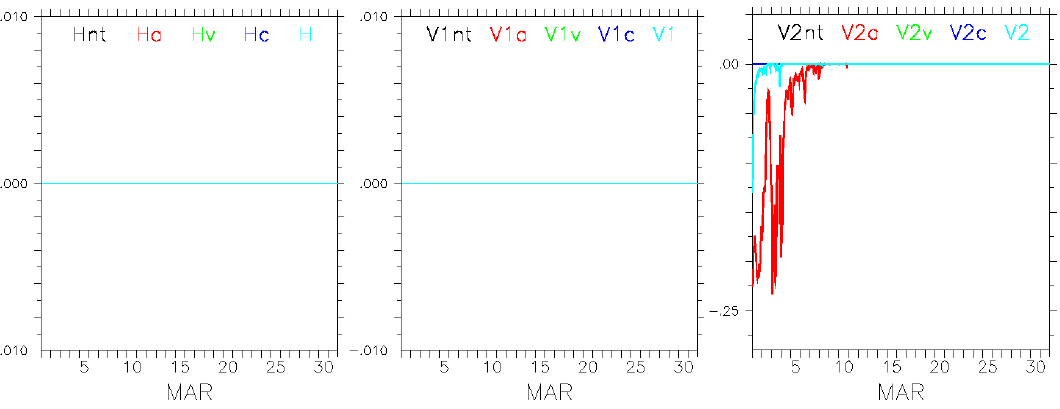
Fig. 5. Corrected negative tracer mass (see text) in kg for the passive tracers H (left), V 1 (middle) and V 2 (right) in the COSMO-7 region. For H and V 1 all lines are on top of each